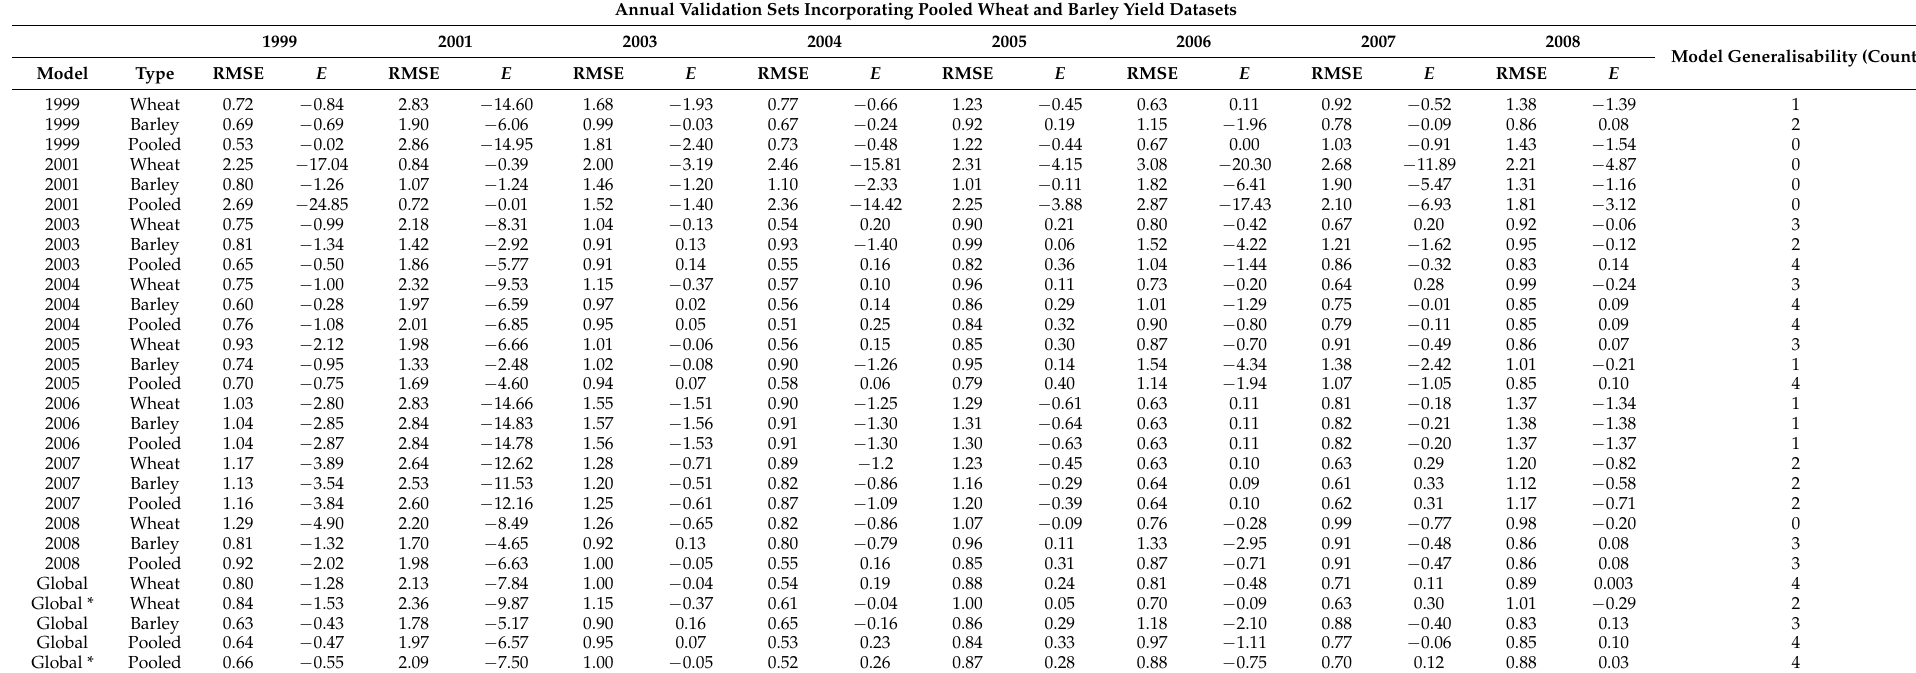
Table A2. Generalisability of the annual crop-specific, annual pooled crop type and global yield prediction models based on root mean square error (RMSE) in t/ha and the Nash–Sutcliffe efficiency criterion ( E ) for each annual pooled crop type validation set. Annual Validation Sets Incorporating Pooled Wheat and Barley Yield